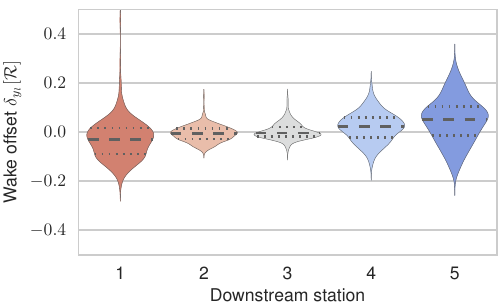
Figure 7. Violin plot of statistics showing the distribution of the frequency of the horizontal wake offset. The dashed lines represent the 25th, 50th, and 75th percentile. δy l is given in rotor radius [ R ].